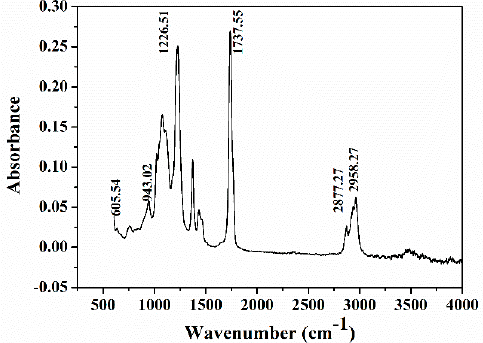
Figure 2. Fourier transform infrared (FT-IR) spectrum of the waterborne fluoropolymer of P1